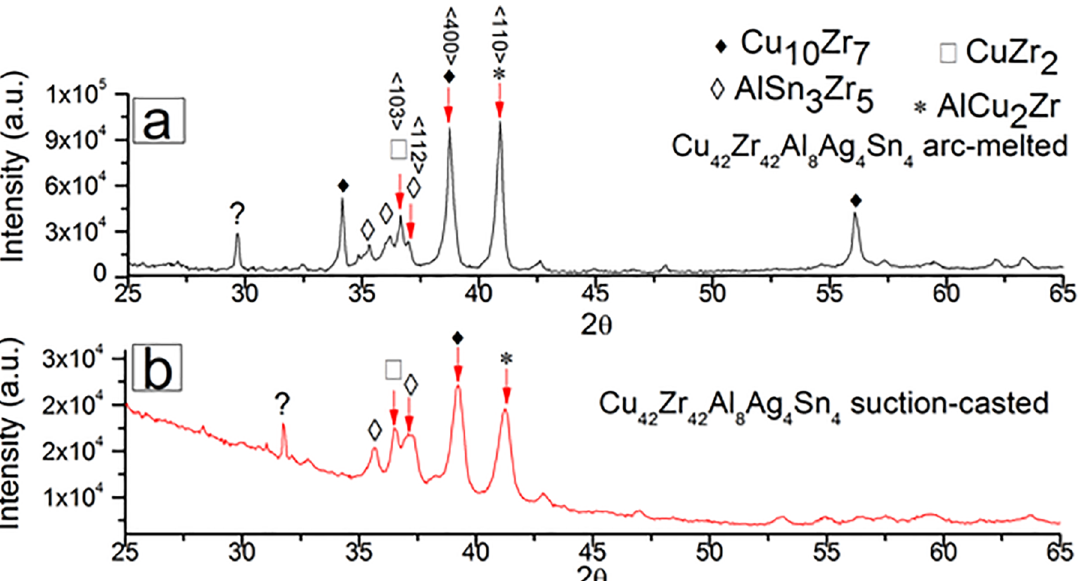
Zr Al Ag Sn , (a) arc-melted and (b) suction-casted. The red arrows indicate the selected peaks 42 42 8 4 4